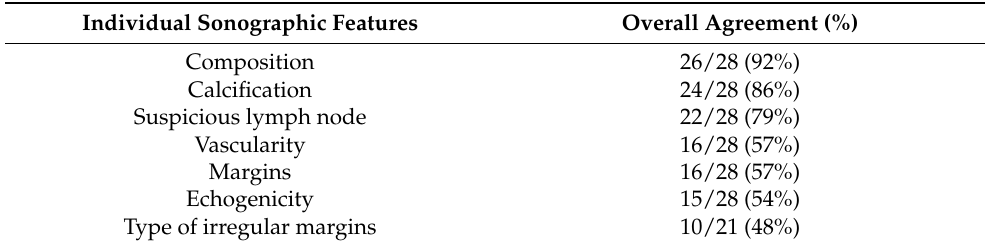
Table 5. Overall agreement rates for nodules that achieved majority consensus but no absolute consensus between raters when classifying for ASR (n =